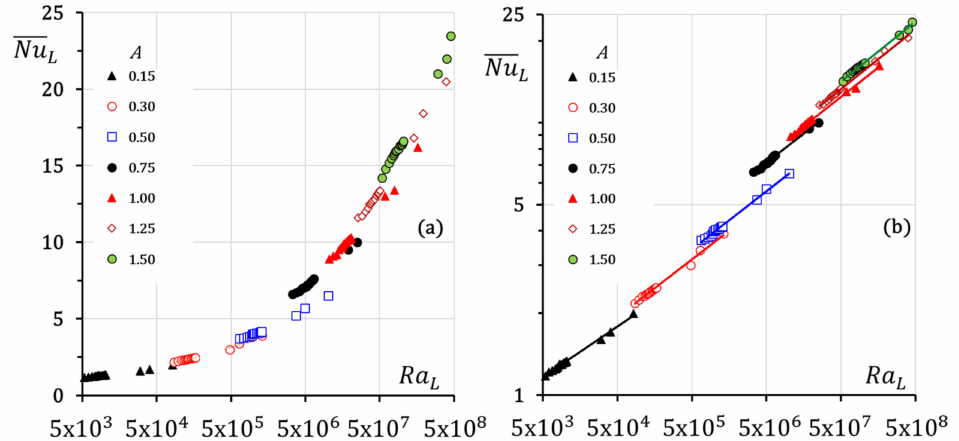
Figure 4. Evolution of Nu L versus Ra